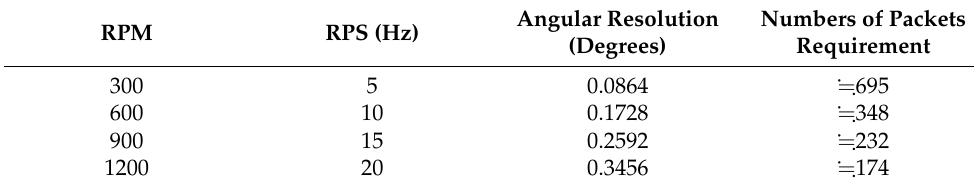
Table 2. HDL-64 rotation rate and the required number of